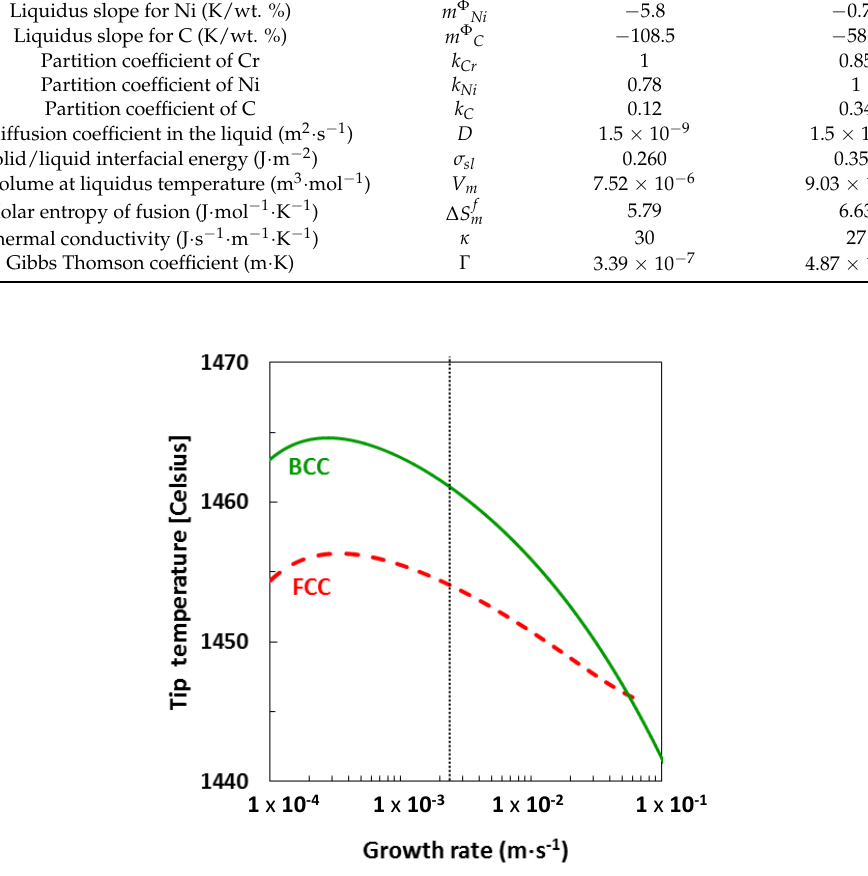
Figure 13. Cell/dendrite tip temperature T* as a function of solidification velocity for the composition (in wt. %): Cr = 15.6, Ni = 8.3, C = 0.05, Fe = bal. Welding speed is indicated by a vertical dashed line.